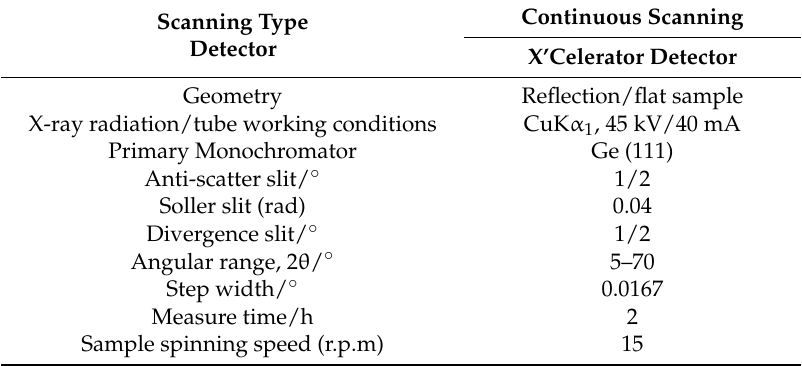
Table 1. The Instrument Settings for X-ray Diffraction